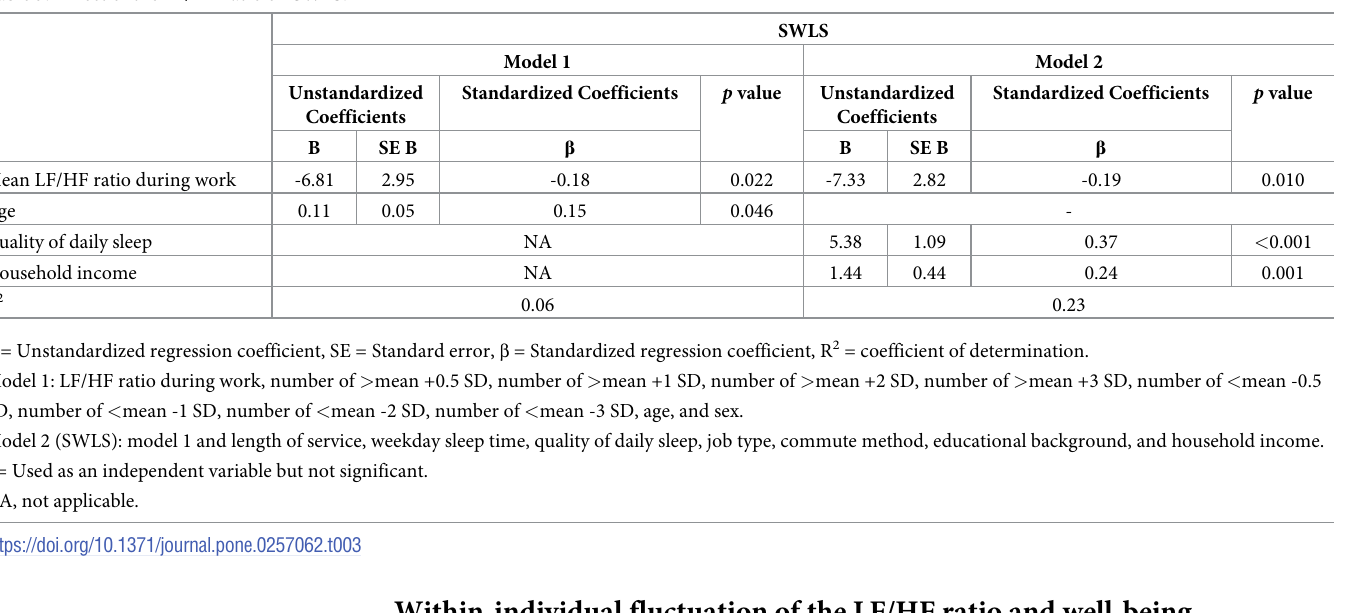
Table 3. Effect of the LF/HF ratio on SWLS.